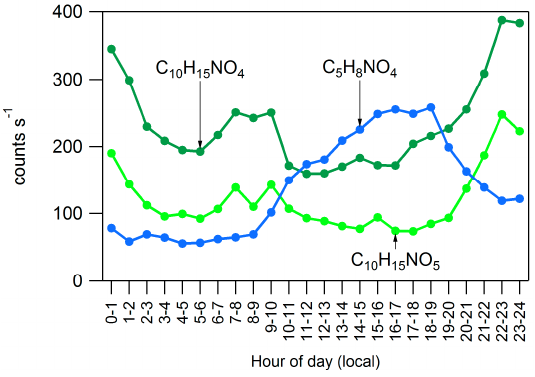
Figure 10. Diurnal plot of gas-phase organic nitrates which appear to have formed from biogenic compounds. These HR-ToF-CIMS data are taken from the high-concentration period of 11–14